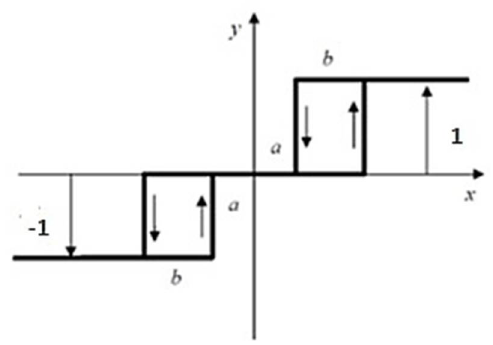
Figure 5. Operating scheme for nonlinear element (N).